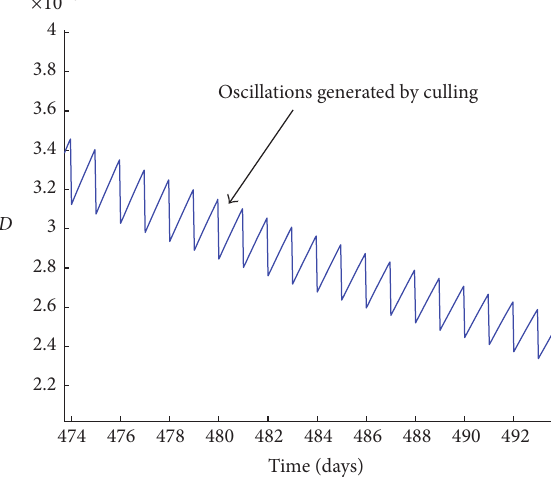
Figure 26: Zoom on the evolution of the asymptomatic subpopula- tion with a daily culling rate of 𝜌 𝐷 = 0.1 .